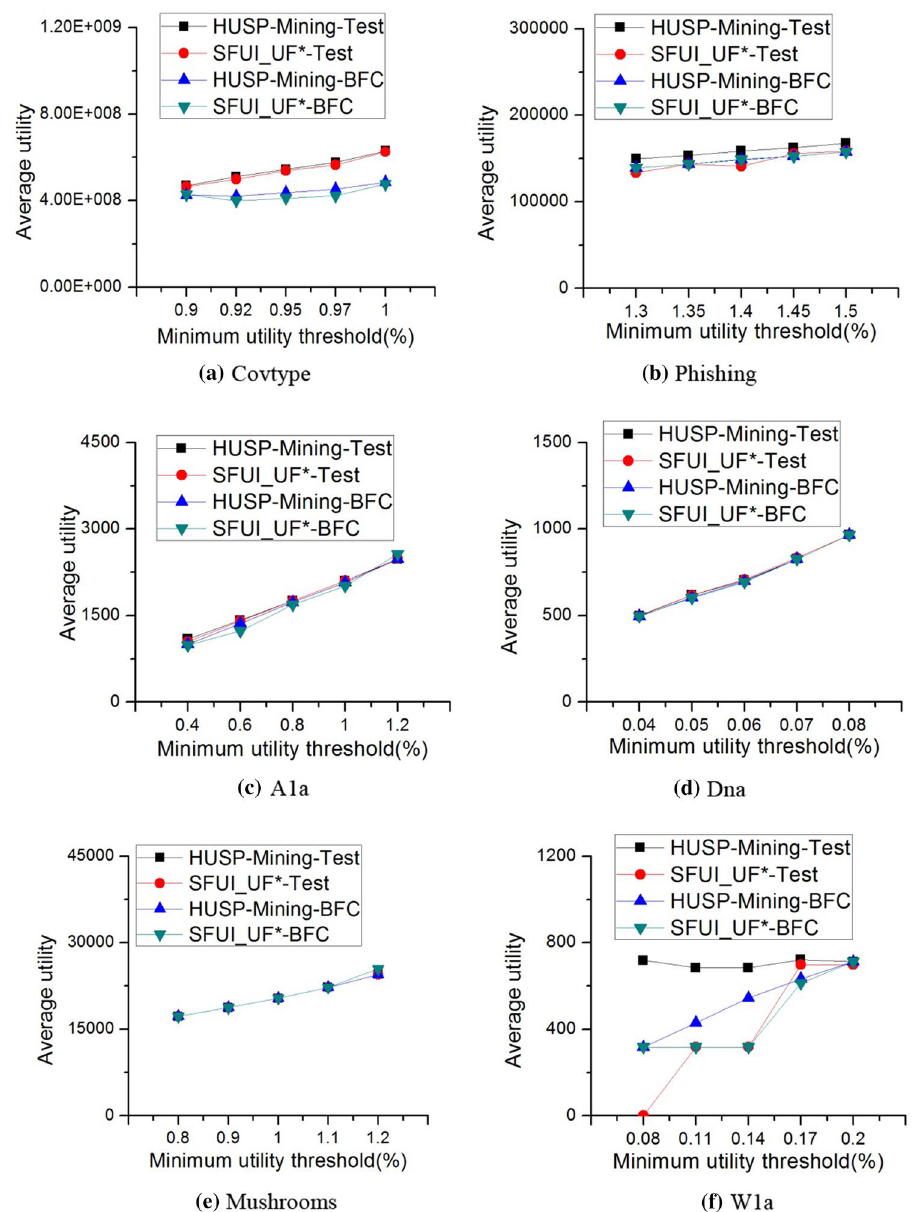
Fig. 13 Average utility